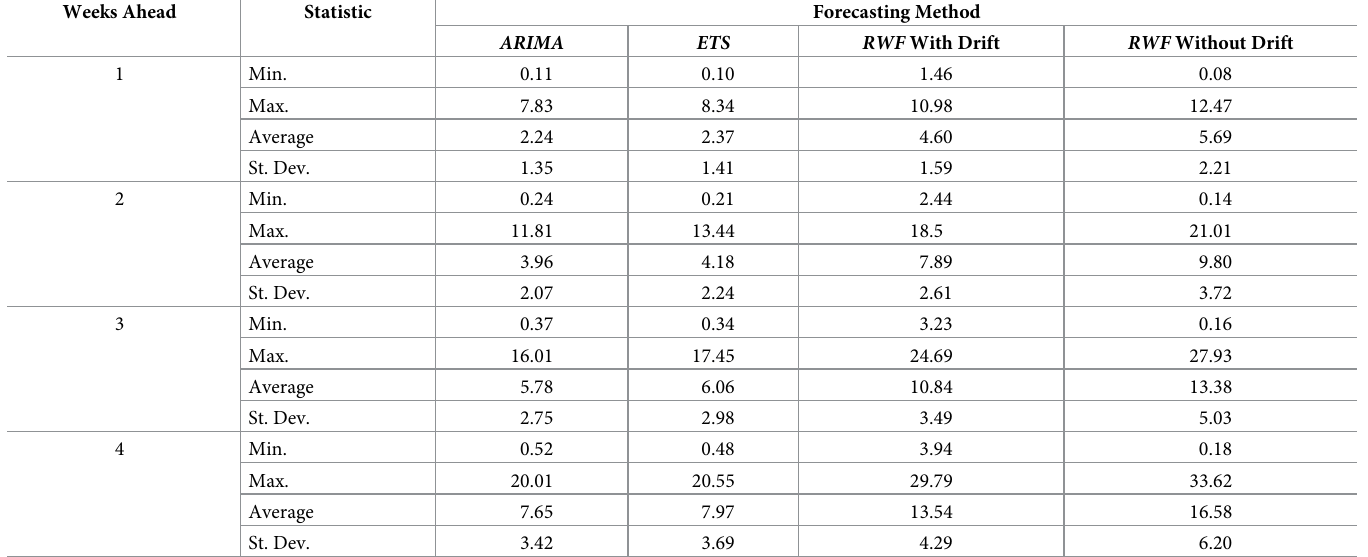
Table 3. Summary of the MAPE results for 187 countries and at the aggregated level of the